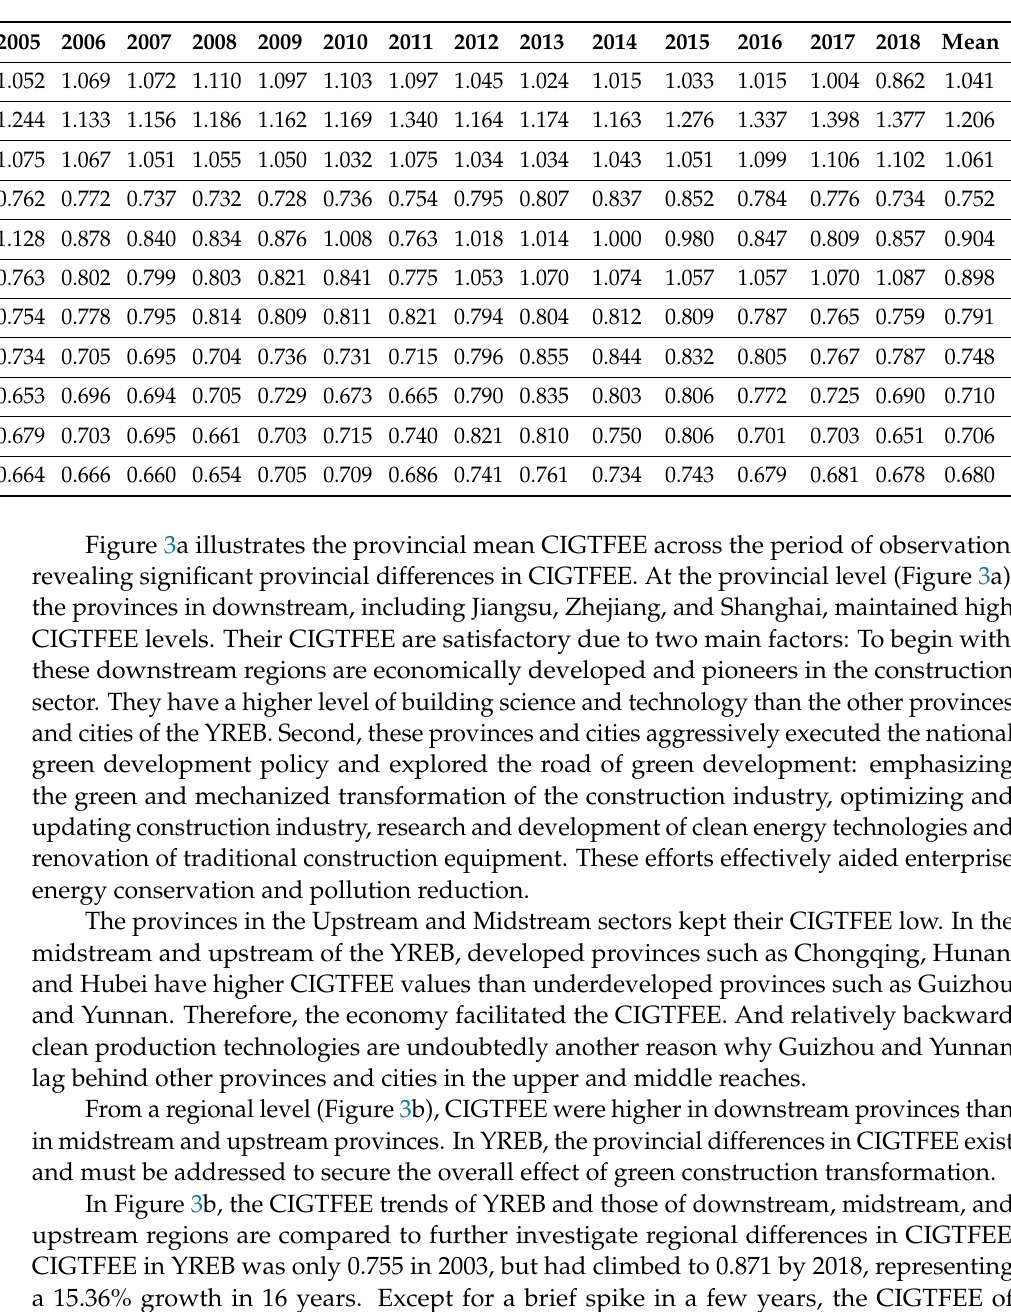
Table 2. Details of the CIGTFEEs of 11 provinces in YREB from 2003 to